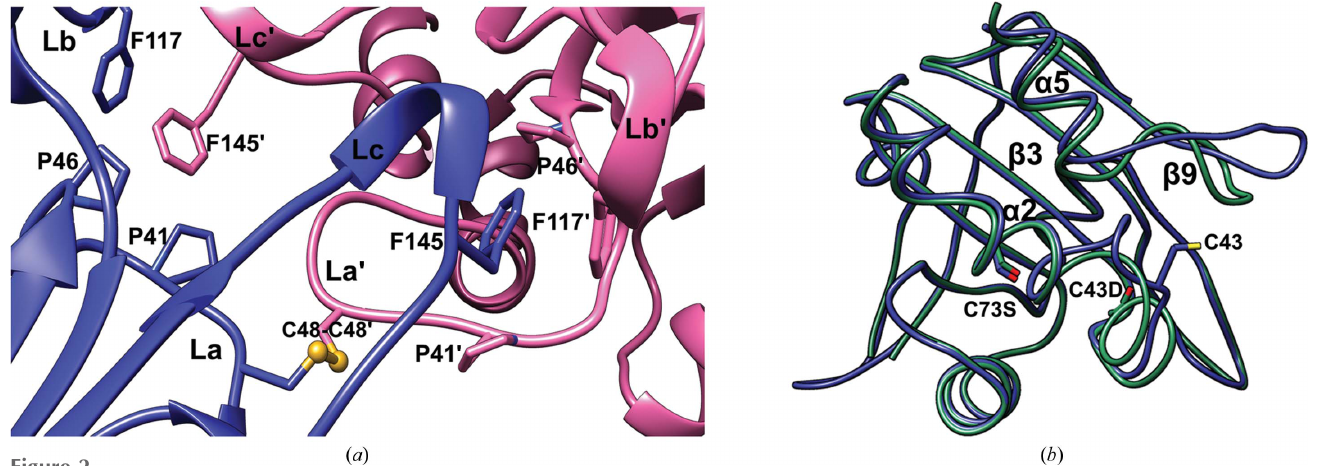
Figure 2 Structural comparison of Vv Prx3 in reduced and oxidized states. ( a ) A magnified view focusing on the interactions at the C-type interface (Fig. 1 c ; red circle) with the intermolecular disulfide bond present between Cys48 residues. The side chains involved in the hydrophobic core are shown in ball-and- stick representation. The loops in this interface are labelled La, Lb and Lc, indicating the loop connecting (cid:2) 3 and (cid:3) 2, the loop connecting (cid:2) 6 and (cid:2) 7, and the loop connecting (cid:2) 9 and (cid:3) 5, respectively. Primes are used in the labels to distinguish the protomers. ( b ) Structural superposition of Vv Prx3 in the reduced form (green) and the disulfide-bridged (oxidized) form